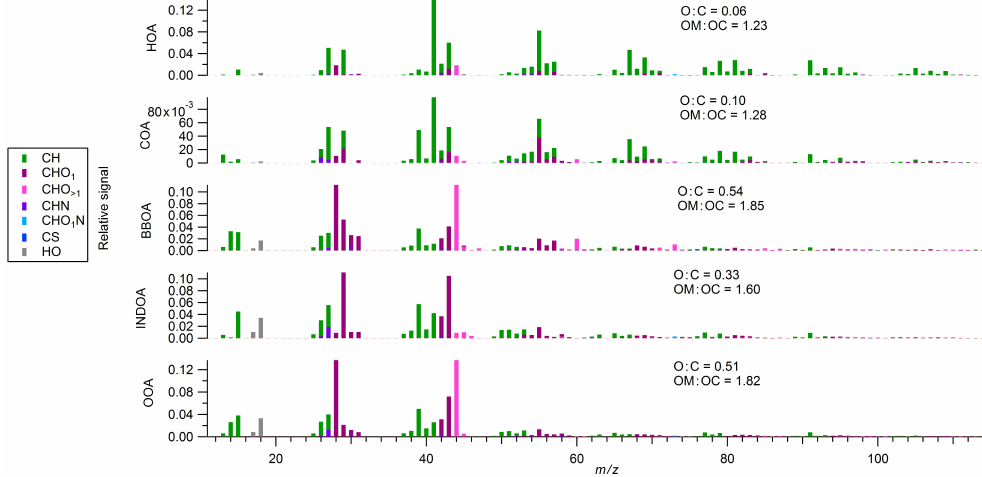
Figure 5. Offline-AMS: water-soluble average mass